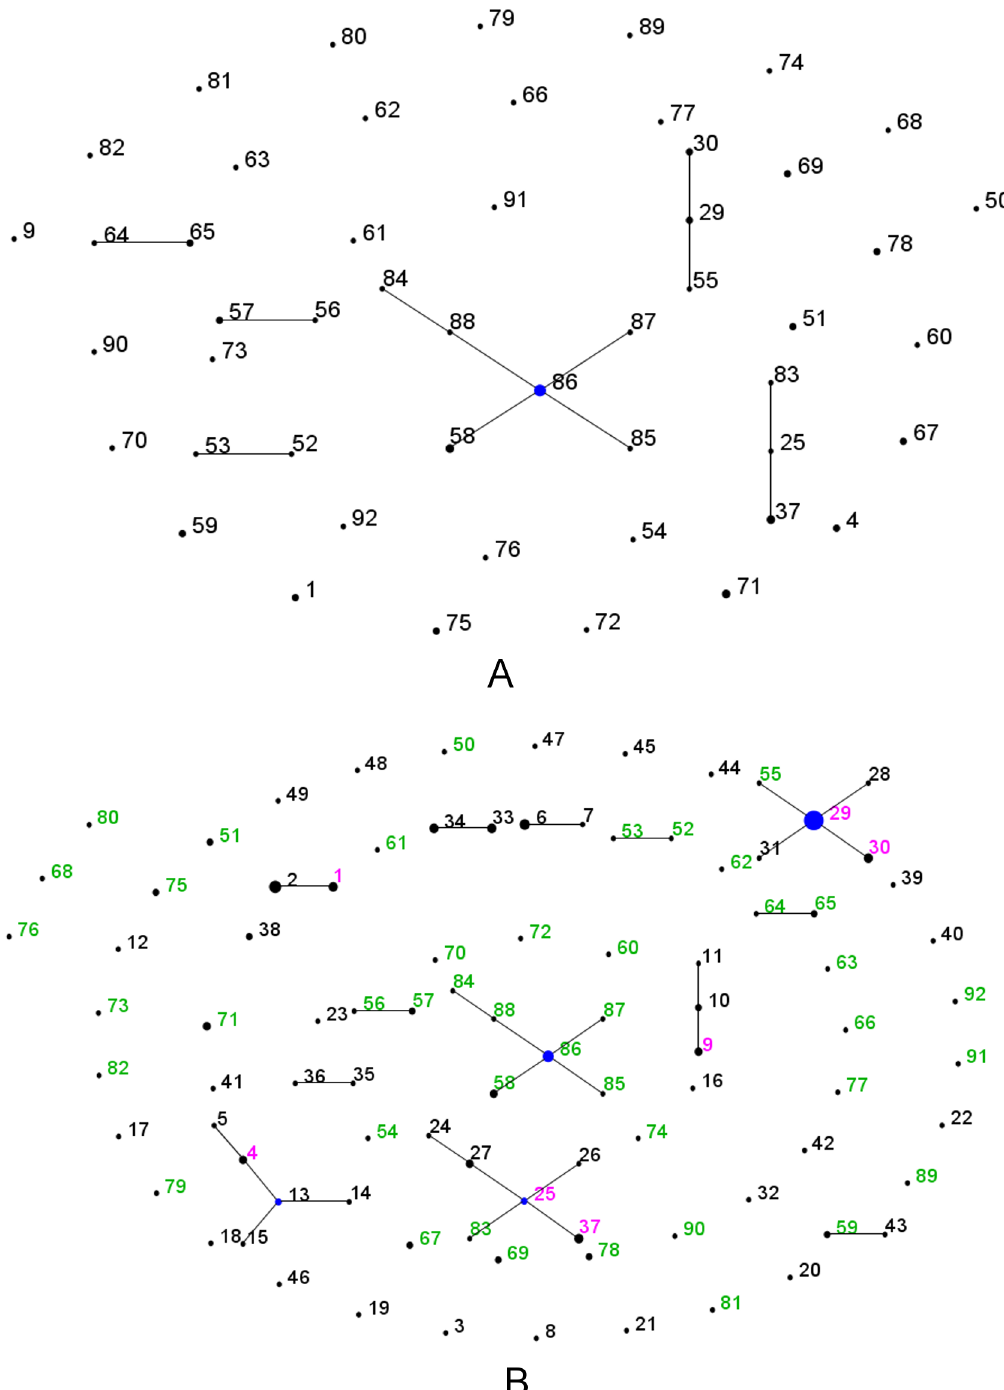
Fig 2. Population genetic structure of O . tsutsugamushi in Laos and Thailand. (A) O . tsutsugamushi population in Laos (n = 74). (B) The comparison of O . tsutsugamushi population in Laos and those in Thailand (n = 89) using comparative e-BURST in which blue dot were founders; pink letter were STs found in both sites; green letter were the STs found only in Laos and black demonstrated the ST found only in Thailand.